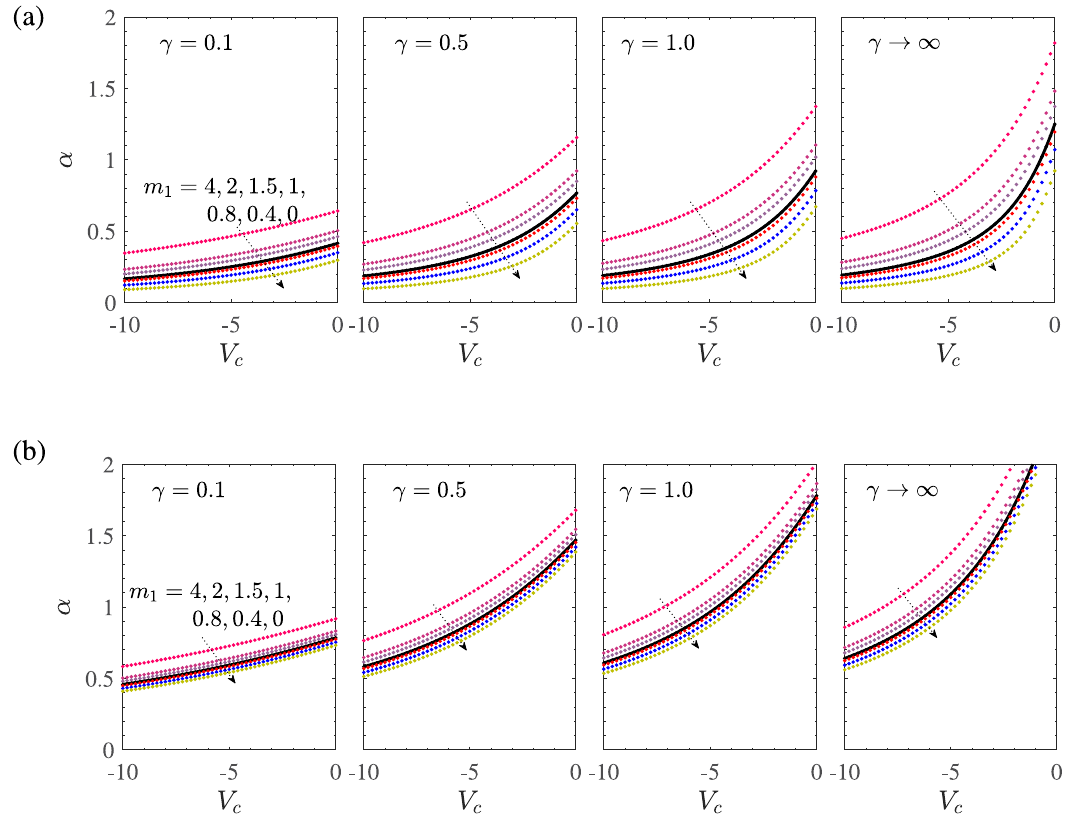
Fig 9. α vs V for γ 1 = 0.1 = − γ 2 and d = 1 + m 1 for the stretching sheet case with mass suction. Here, unique solutions occur for c m 1 � − 1 − M and the dual solutions occur for m 1 > − 1 − M